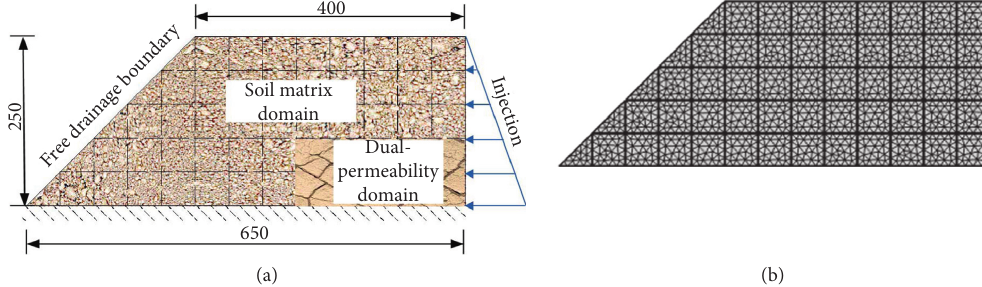
Figure 6: Numerical model of the rare earth pile under a horizontal liquid injection (unit: mm). (a) Geometric model. (b) Element mesh.